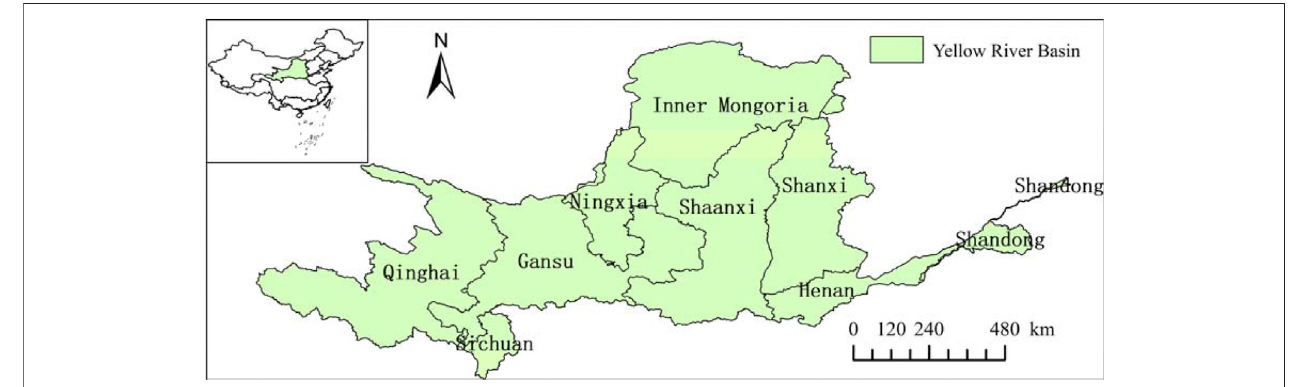
FIGURE 1 | Yellow River basin in China.